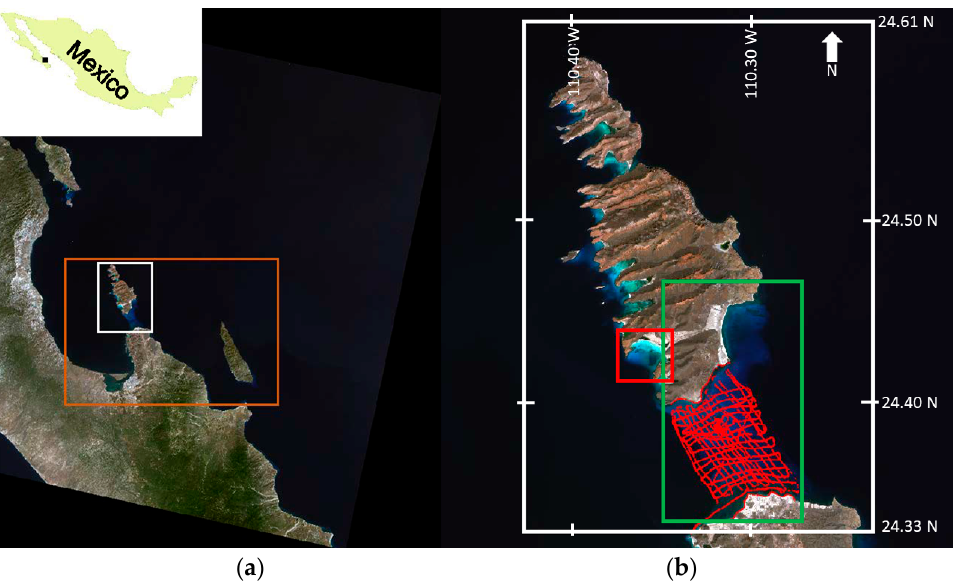
Figure 1. Landsat scene: LC80340432013292LGN00. ( a ) whole image with study area (orange rectangle), and Espiritu Santo island and the SLC (white rectangle); ( b ) red square is the area used for parameter calibration, and green rectangle is the SLC.